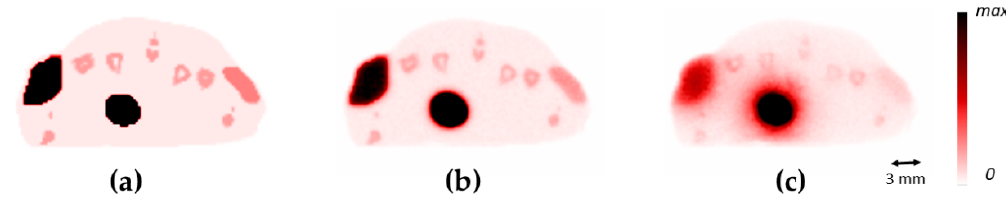
Figure 3. Comparison of cross-sections of the mouse between the emission image ( a ), the 18 F positron annihilation image ( b ), and the 68 Ga positron annihilation image ( c ).